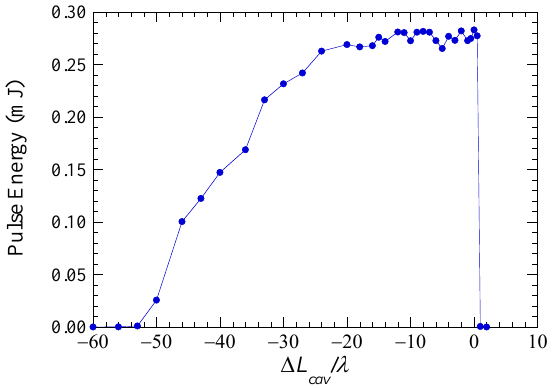
Figure 13. Cavity detuning curve of the IR RAFEL for an on-axis undulator field of B u = 6.658 kG ( K rms = 1.055), while the other parameters are given in Table 1.